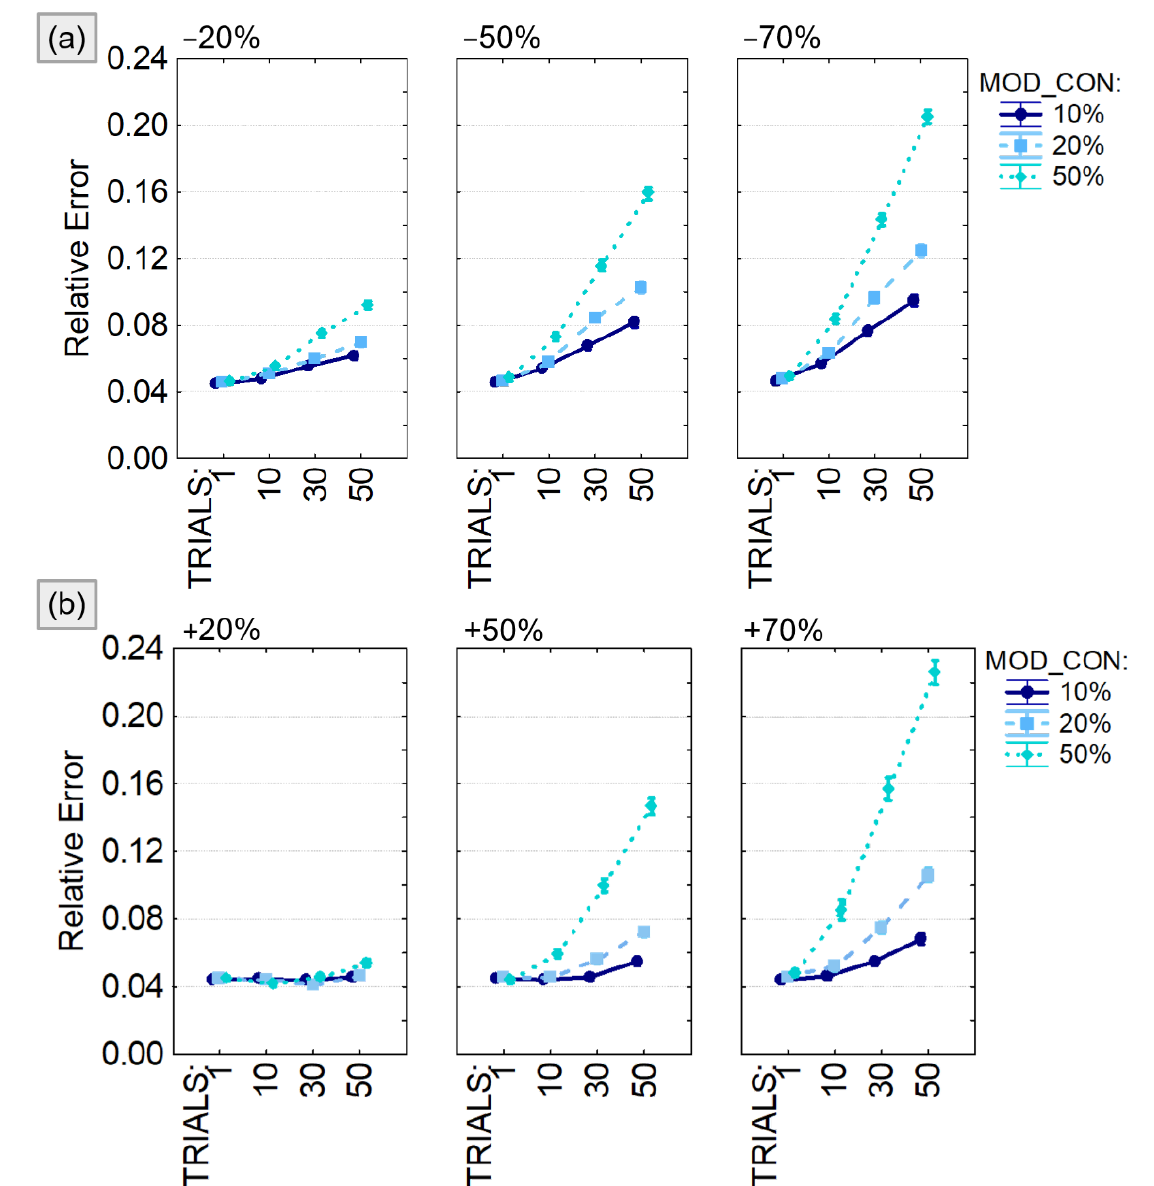
Figure 5. PDC percentage estimate error with respect to the imposed connectivity model. Results of the four-way ANOVA performed using Relative Error as dependent variable. The investigated factors are: the number of connections with variable weight (MOD_CON), the amplitude of the weight variation quantified as percentage of the initial value (VAR), the percentage of modified trials (TRIALS), and the type of variation (number of connections on which to apply a value variation (VAR_DIR) which can be either a reduction (panel a ) or an increase (panel b ). The bars represent the 95% confidence interval.